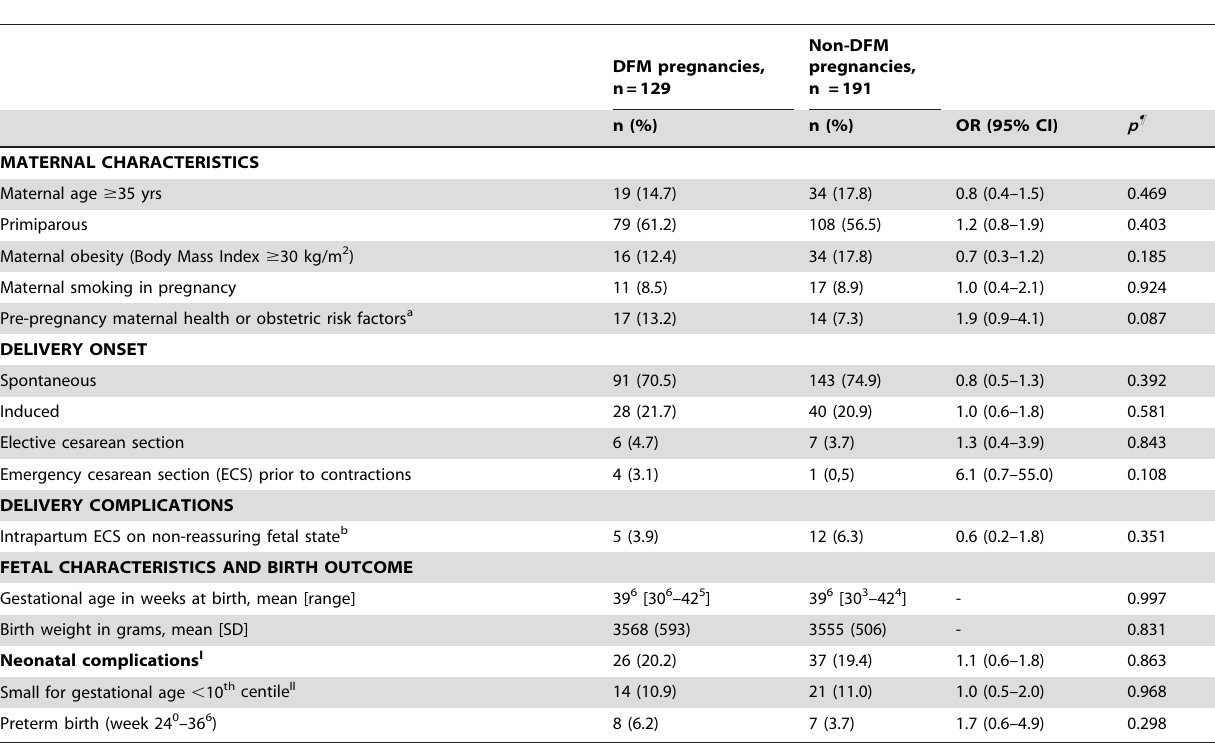
Table 2. Maternal and fetal characteristics and birth outcome for DFM versus non-DFM pregnancies, from pregnancy week 24 0